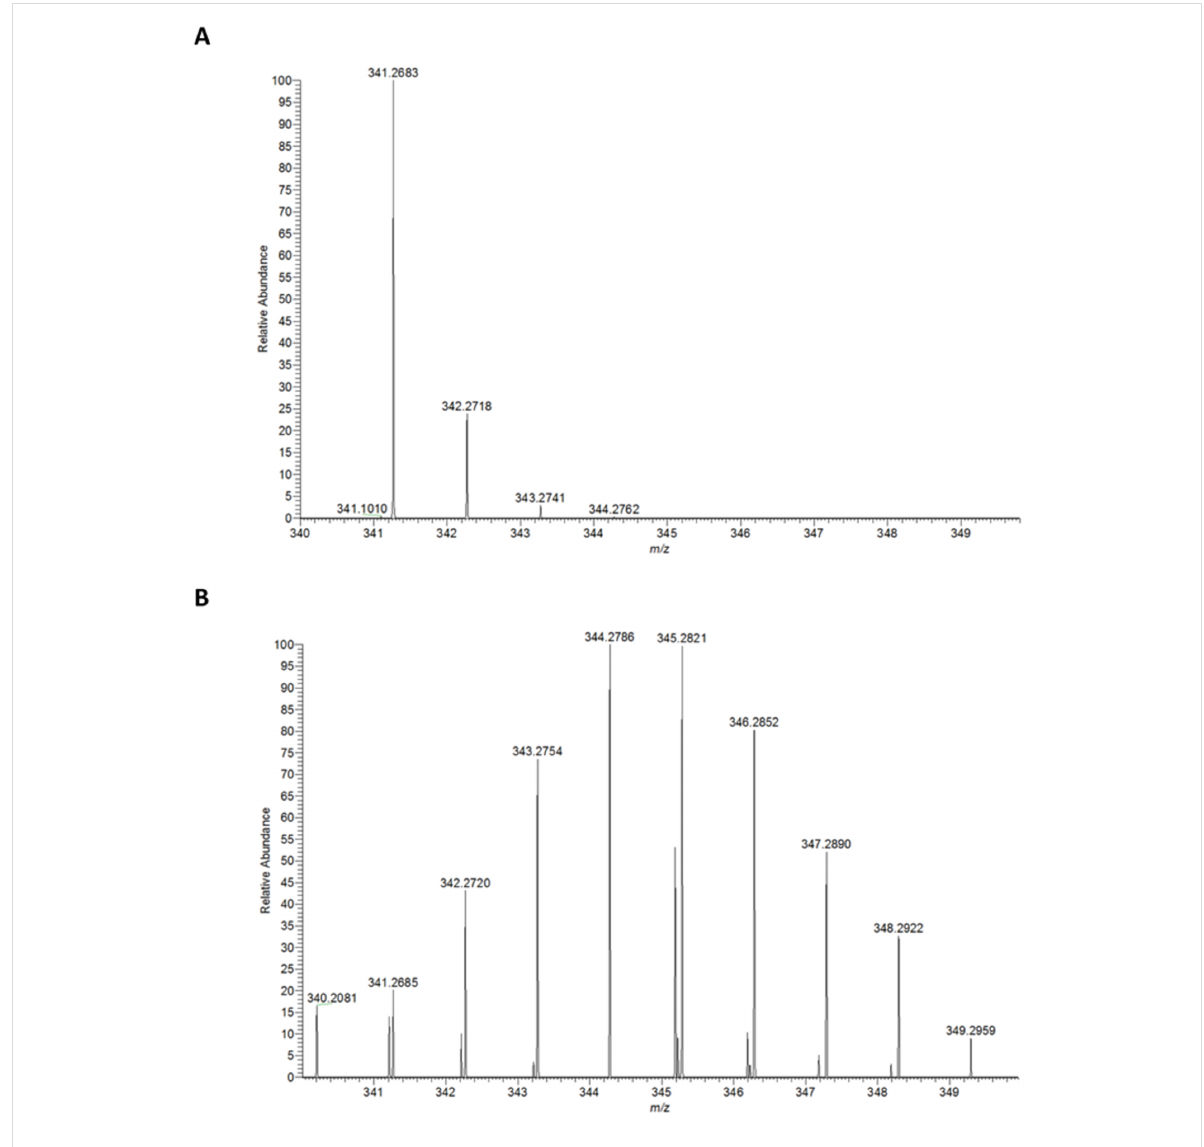
Figure 2: High-resolution mass spectra of a metabolite from H. aurantiacus obtained after feeding of unlabeled (A) and [1- 13 C]-labeled D-glucose